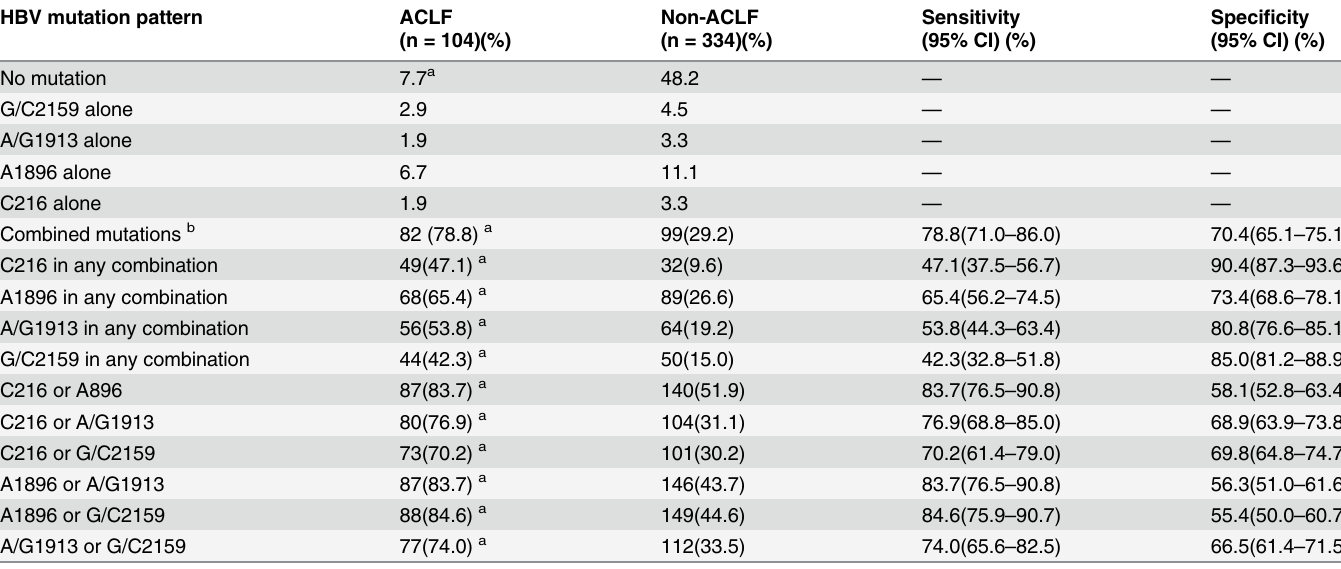
Table 7. Sensitivity and specificity of specific mutation patterns of hepatitis B virus for